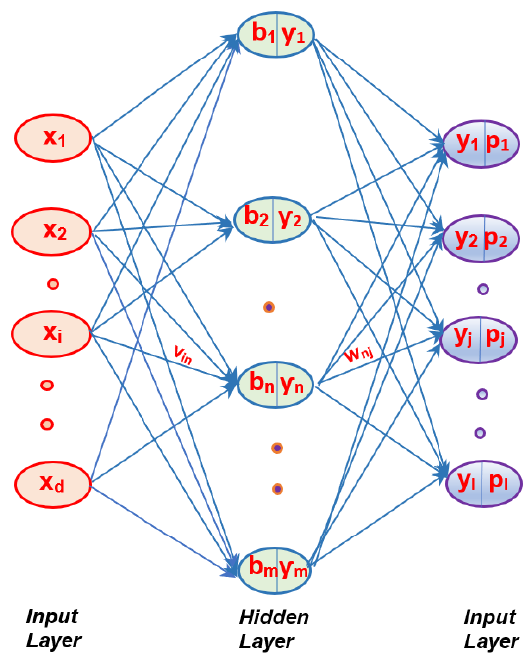
Figure 3. Backpropagation neural network structure.